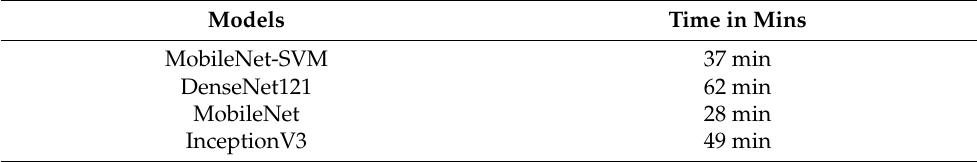
Table 8. Computational time of the